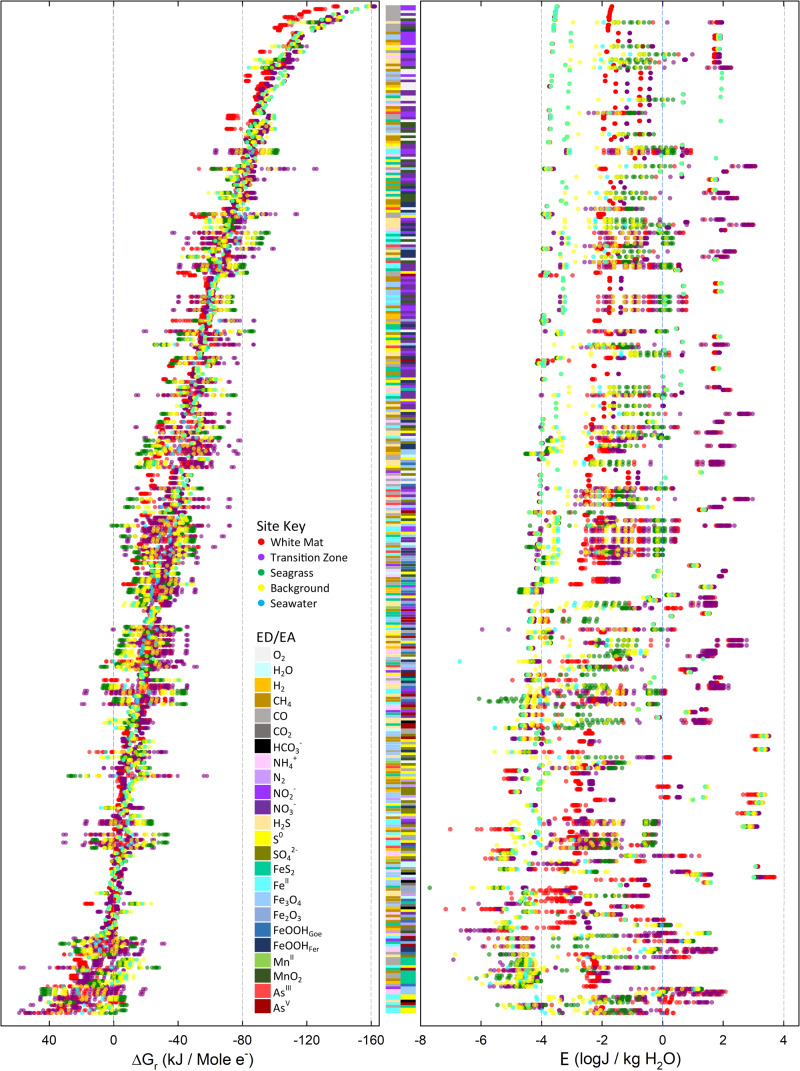
Overall Gibbs energy yields of the catabolic reactions considered in this study.Circles refer to values of ΔGr of the 379 exergonic reactions shown in S2 Table at individual sample sites in units of kJ/mol e- (A) and J/kg fluid (B). The colors of the circles encode for the five biogeographic regions (see key). The colored bars in the middle of the two panels refer to the identities of electron acceptors and donors in the reactions as noted in the key. The reactions are ordered from most exergonic at the top to least exergonic at the bottom, based on the averages of ΔGr values from all samples.